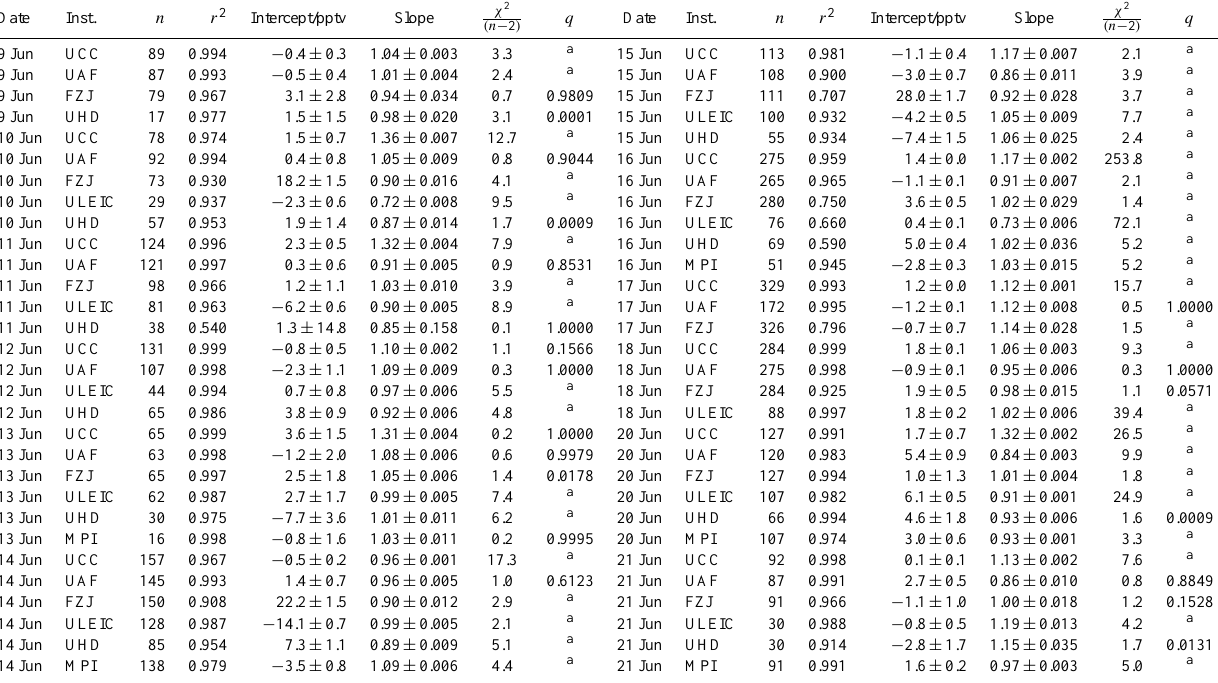
Table 4. Results of the correlation and linear regression analysis of all instruments versus NOAA-CRDS for each experiment. Data are 3min averages.